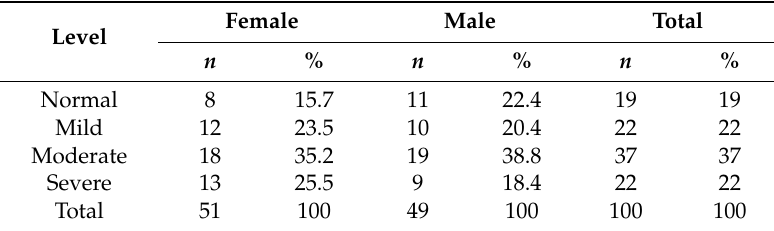
Table 1. Hopelessness levels of the participants with respect to sex.